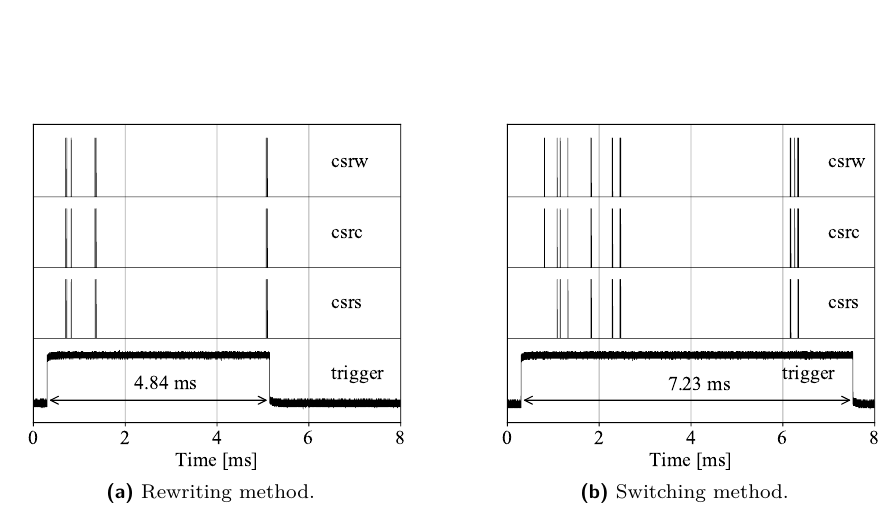
Figure 9: Positional relation between trigger and execution timings for target instructions. The trigger signal becomes high-level logic during the attacker application running